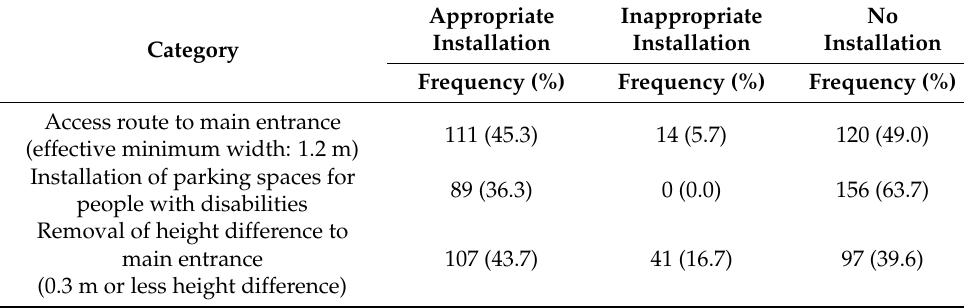
Table 3. Installation state of intermediary facilities.